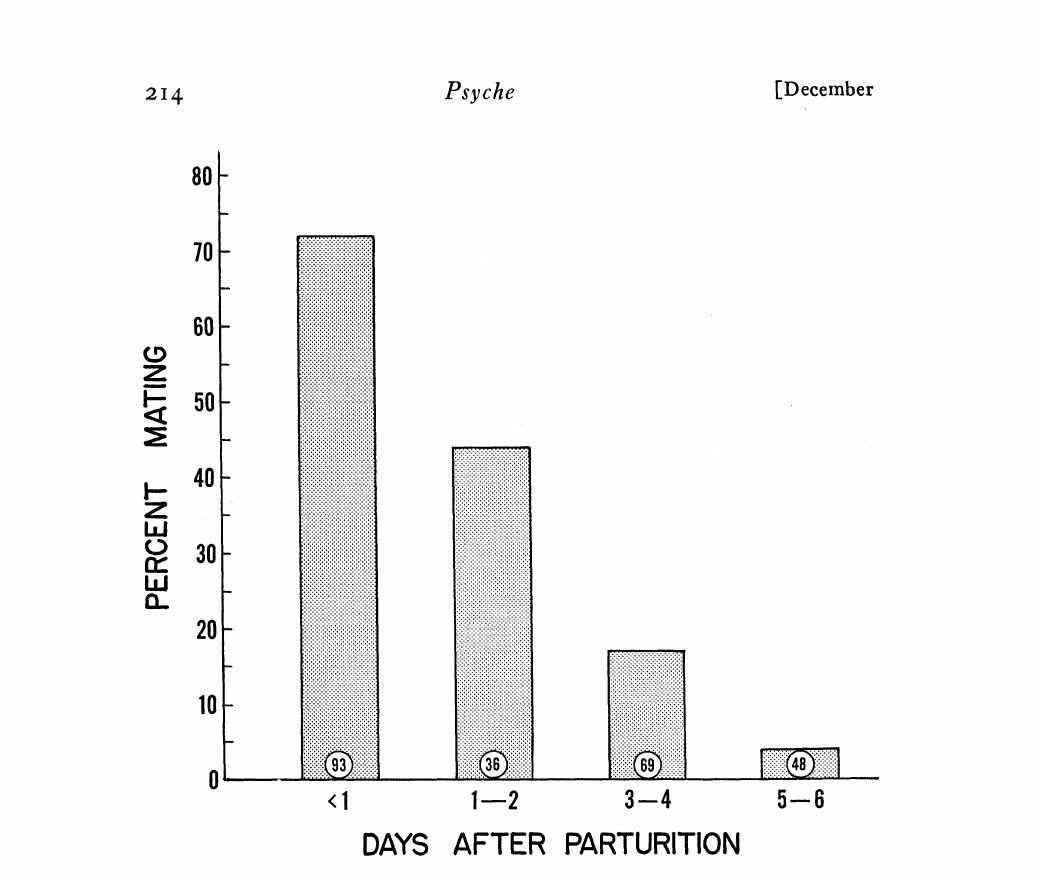
Fig. 10. Effect of delayed exposure to males on receptivity of females following parturition in N. cinerea. The axis of abscissas indicates the days after parturition the females were placed with males. Numbers in circles indicate the numbers of females used. Gestation period 35-50 days. Females fed during gestation and after